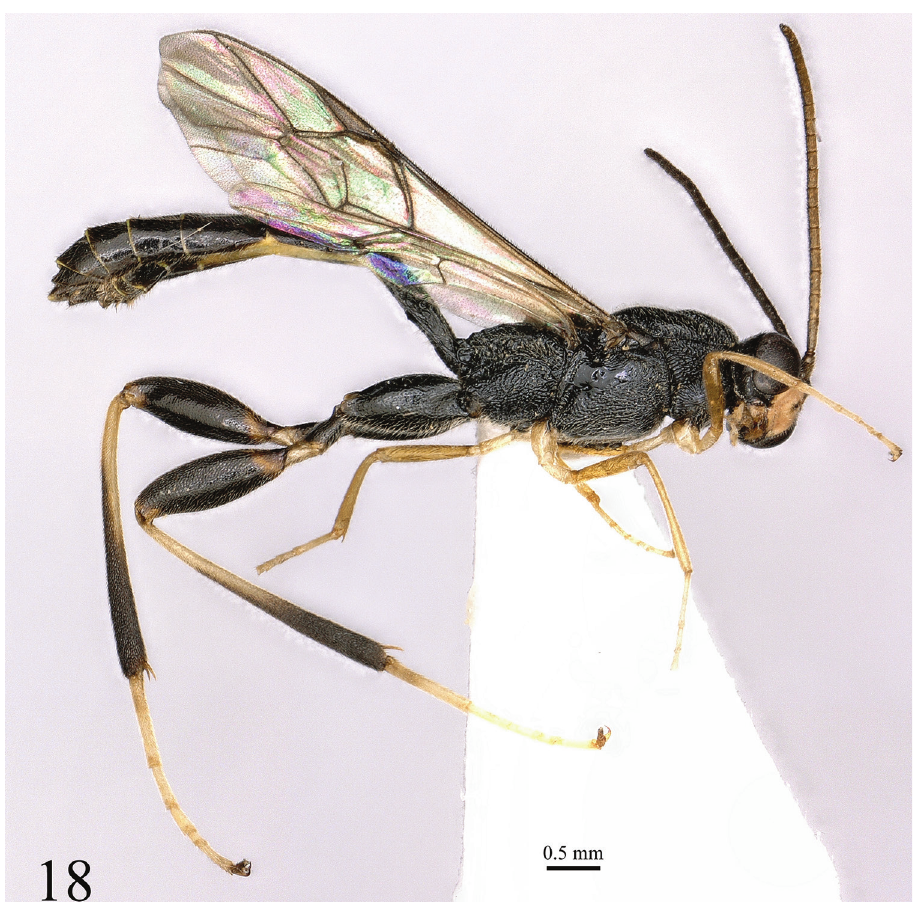
Figure 18. Bicurta hejunhuai sp. nov. (male, paratype) habitus, lateral view. Wings . Fore wing (Fig. 11) with vein 1cu-a distad of M&RS by 0.2× length of 1cu-a; 2rs-m basad 2m-cu by 0.83× length of 2rs-m. Hind wing with 8 distal hamuli; CU & cu-a reclivous, distinctly intercepted at upper 0.27; distal abscissa of CU weakly pigmented. Legs . Fore and mid legs slender. Hind coxa elongate, 3.2× as long as its maximum width, sparsely punctulate, punctures on dorsal area sparser. Hind femur (Fig. 17) 2.8× as long as its maximum width. Hind tibia 1.9× as long as hind femur; tibial spurs very short, inner spur equal to outer spur, 0.18× length of hind basitarsus. Ratio of length of first to fifth hind tarsomeres as follows: 5 : 2.3 : 1.5 : 1.0 : 2.1. Tarsal claw strongly bent (Fig.